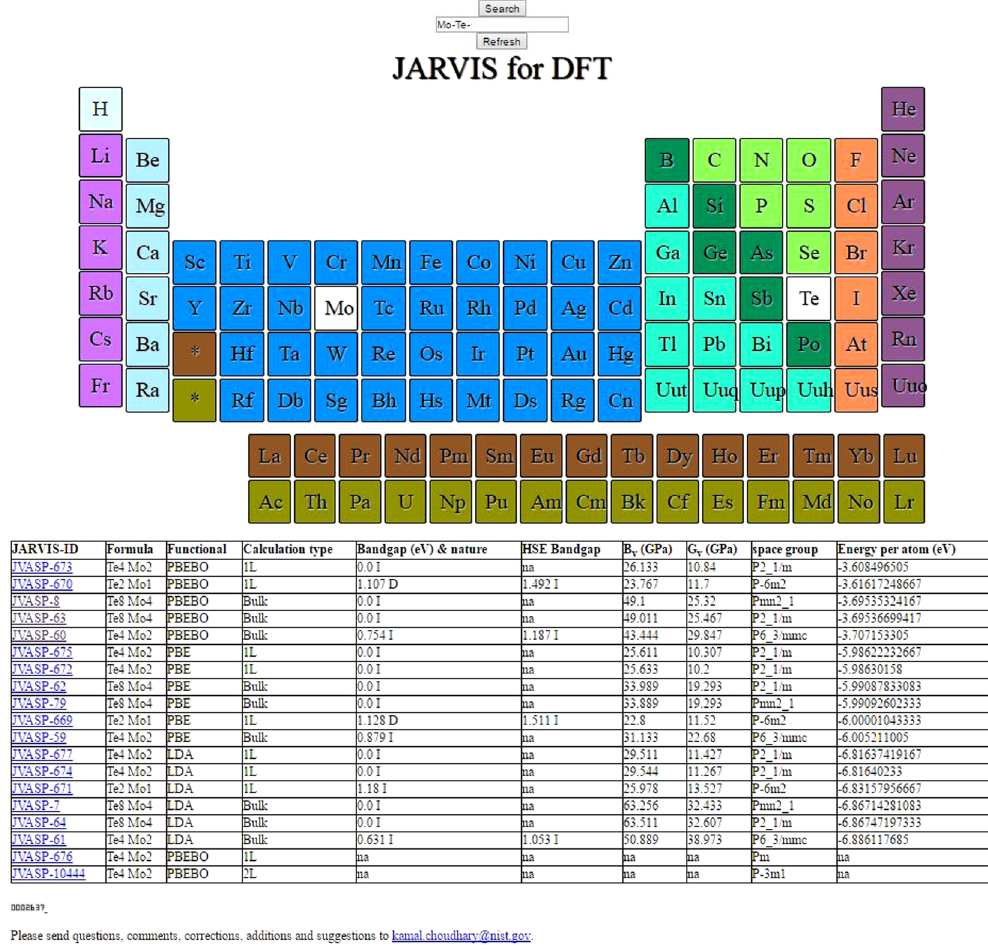
Figure 6. Snap-shot of the web-interface showing the example of Mo-Te as an